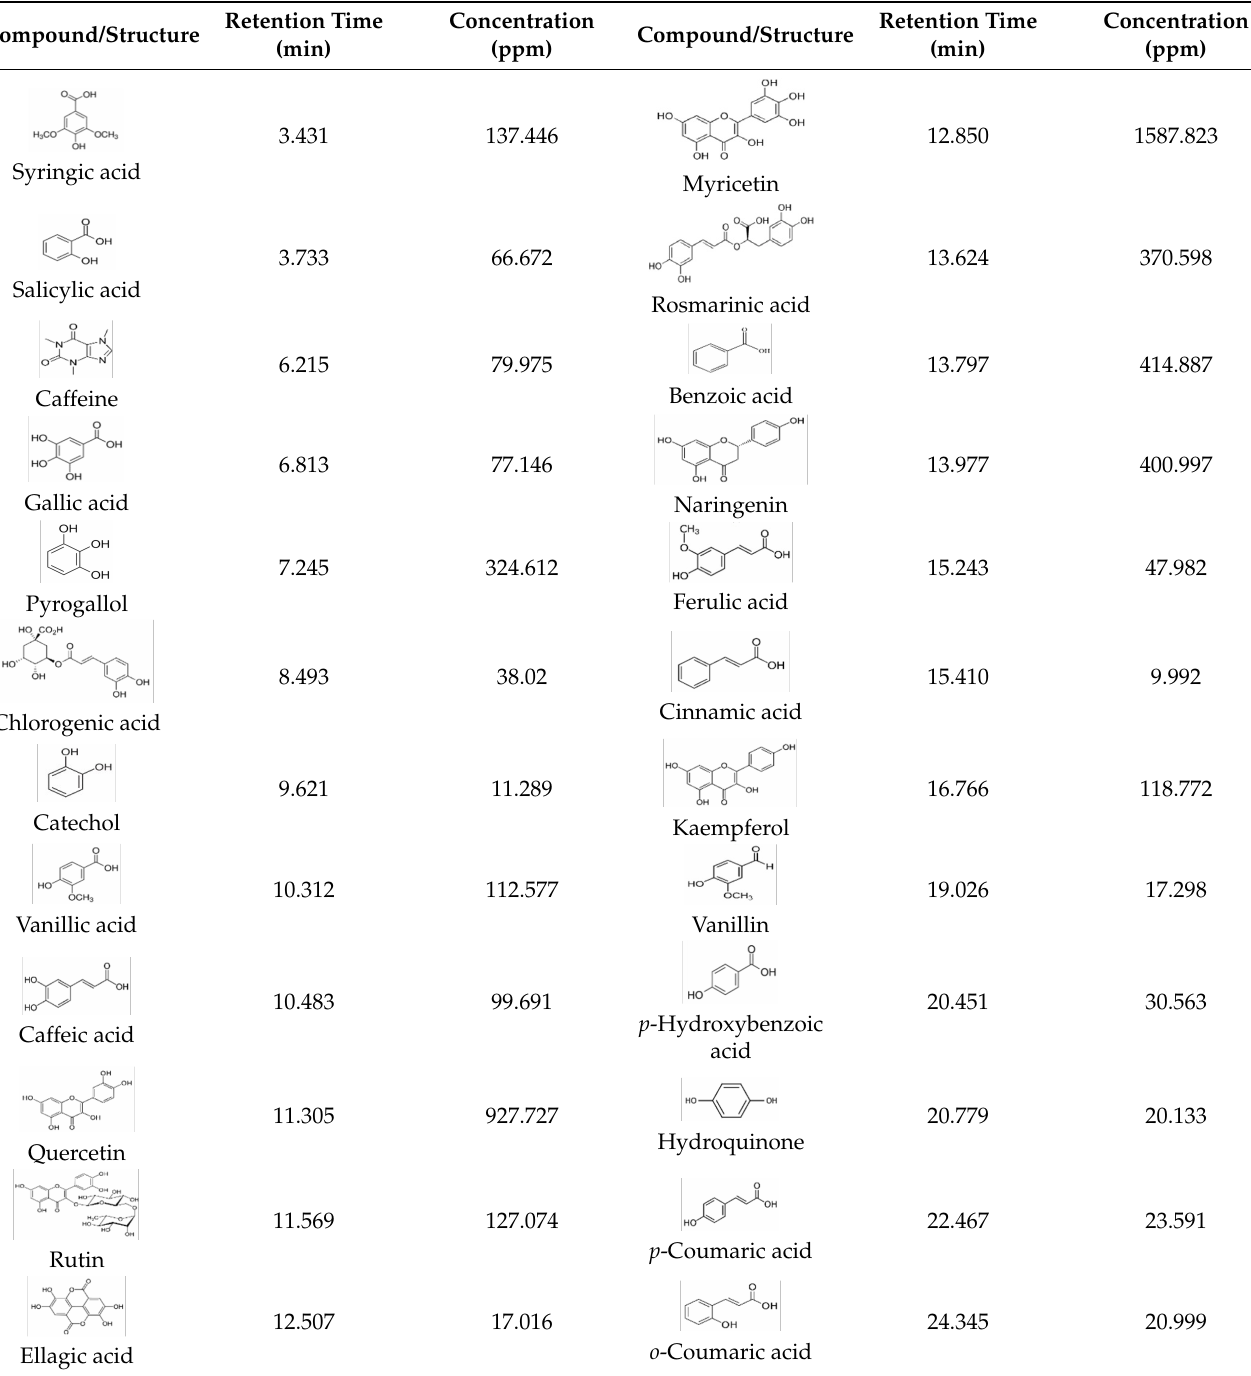
Table 1. Fractionation and identification of phenolic compounds of Matricaria chamomilla flowers extract using HPLC technique.